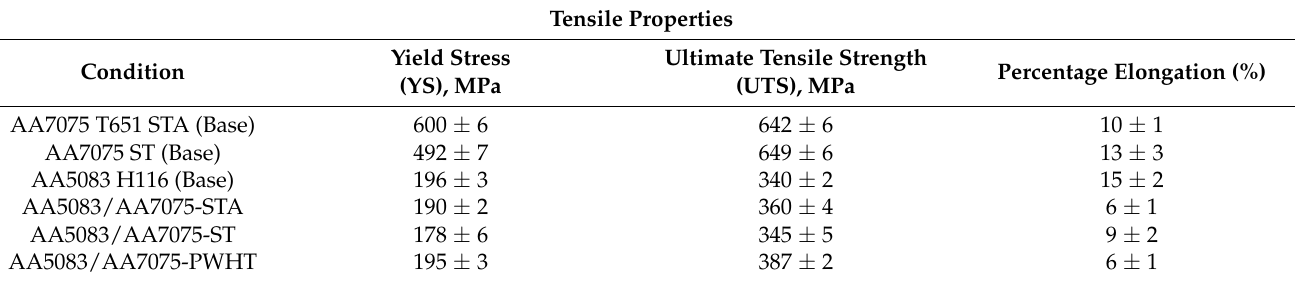
Table 4. Results of tensile tests of base metals as well as the weldments.